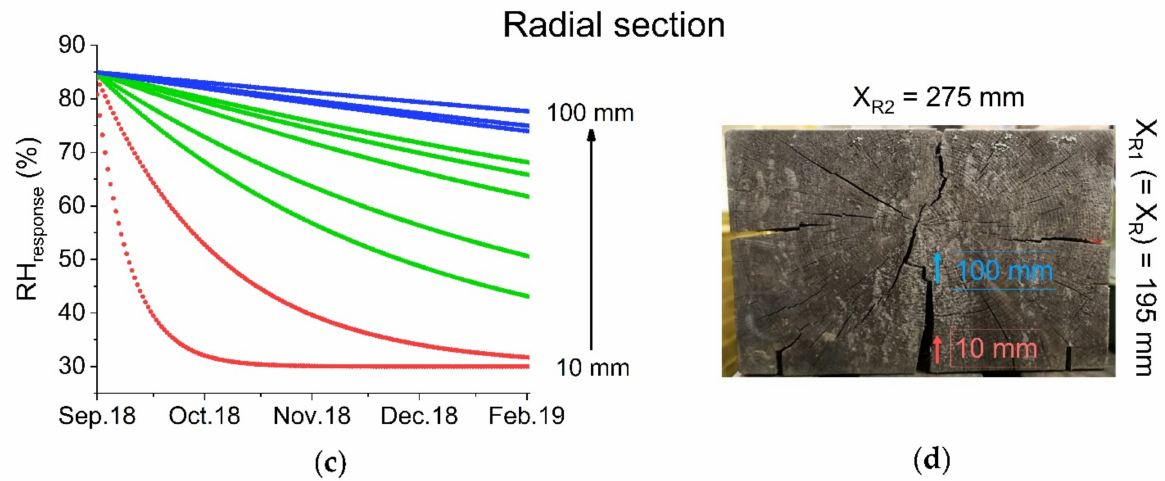
Figure 11. RH response (%) trend along the two main directions. ( a ) RH response along longitudinal direction from slice S1 (10 mm depth) to slice S25 (490 mm depth) over time. ( b ) Longitudinal axis and slices of the beam. ( c ) RH response along radial direction from surface (10 mm) to the pith (100 mm) of the beam over time. ( d ) Radial axis of the beam.